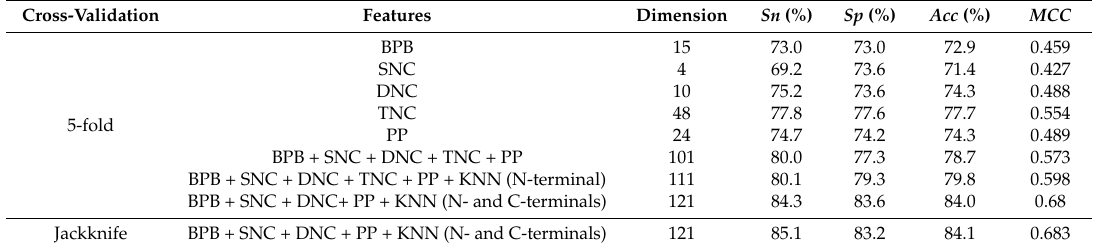
Table 3. The best prediction achieved by single type of features for the second layer. Cross-Validation